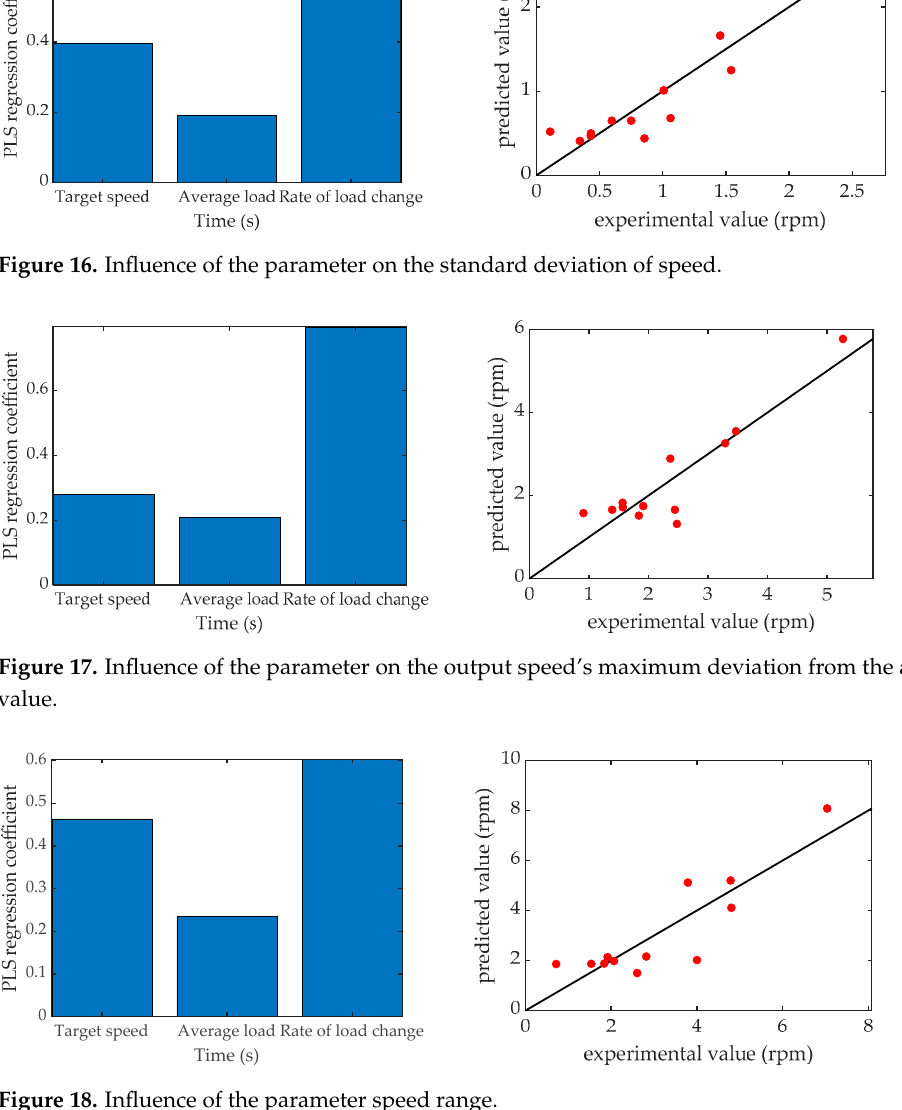
Figure 18. Influence of the parameter speed range.